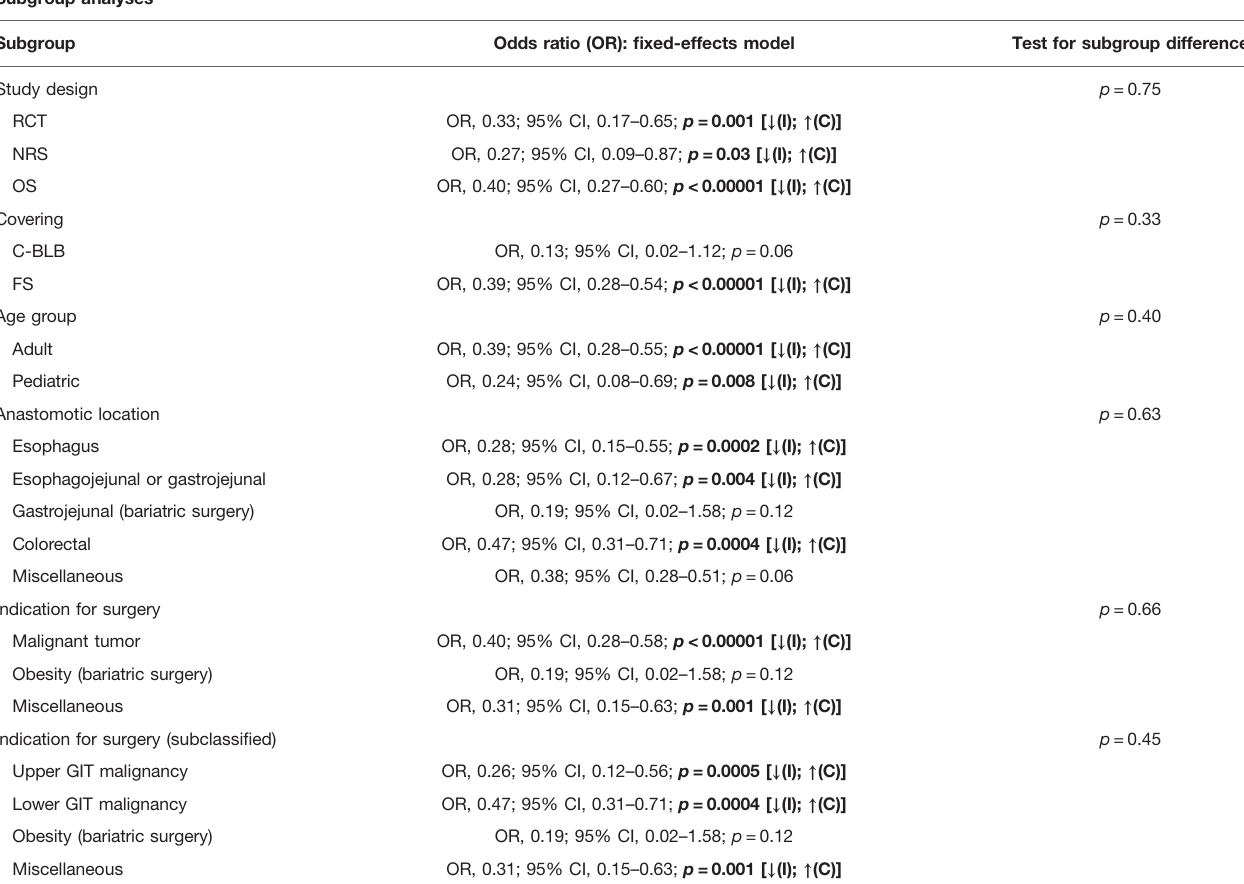
TABLE 5 | Subgroup analyses of fi xed-effects meta-analysis for postoperative anastomotic leakage. Subgroup analyses